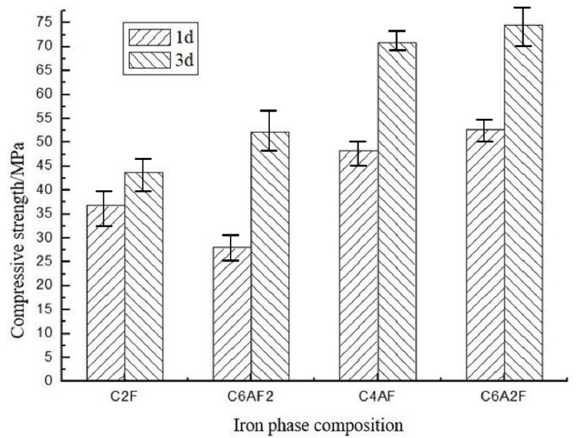
Figure 10. Compressive strength of samples.